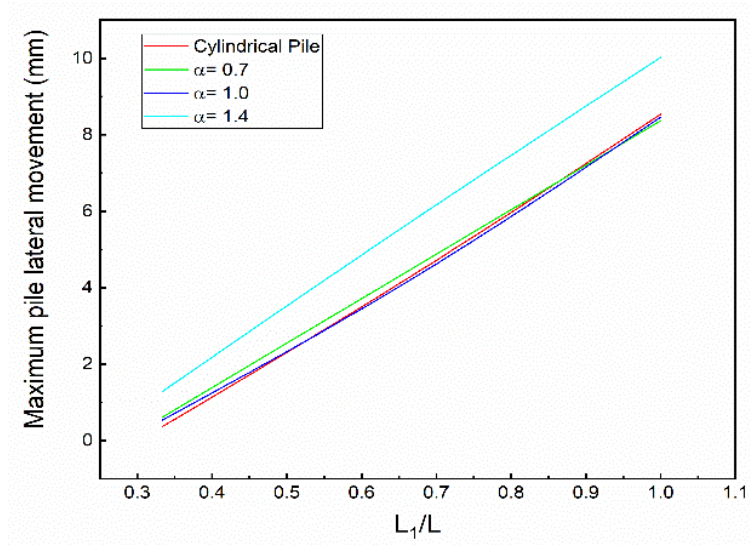
Figure 12. Maximum lateral movement for different pile shapes.